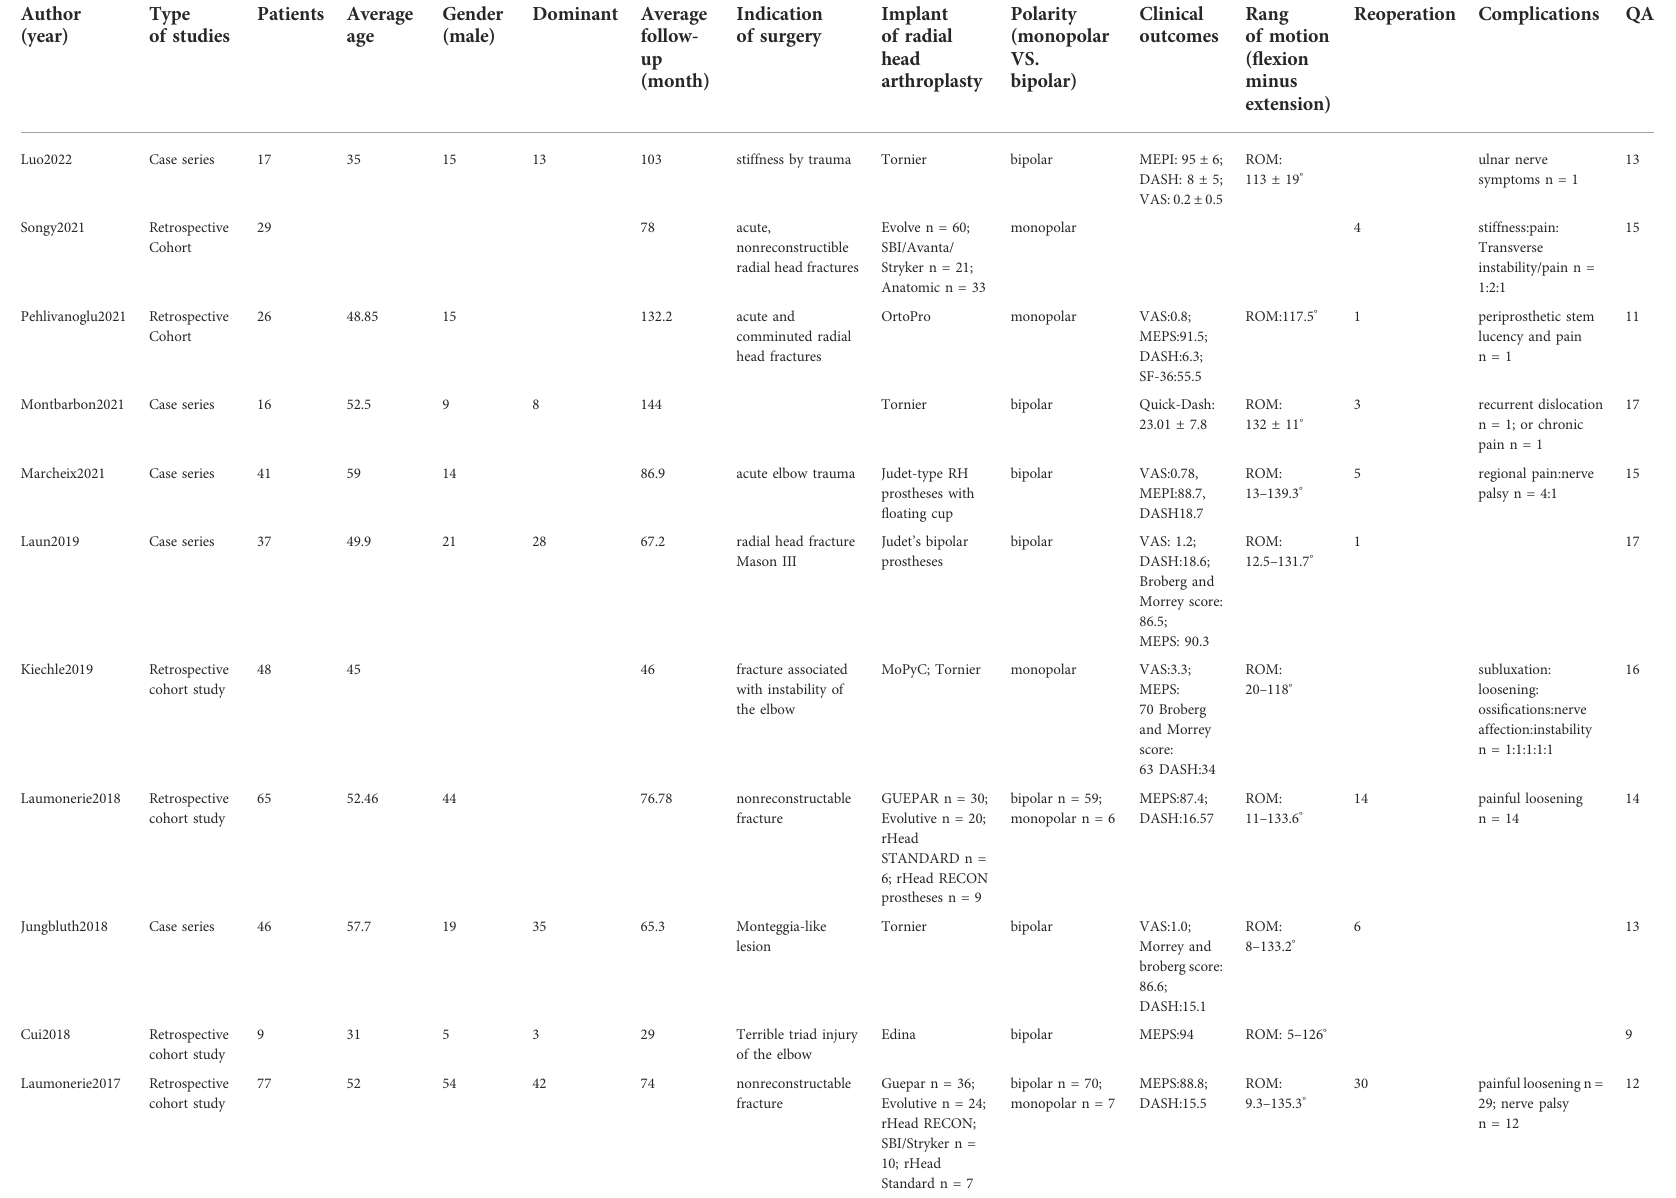
TABLE. 1 Baseline demographics of the selected studies for cemented fi